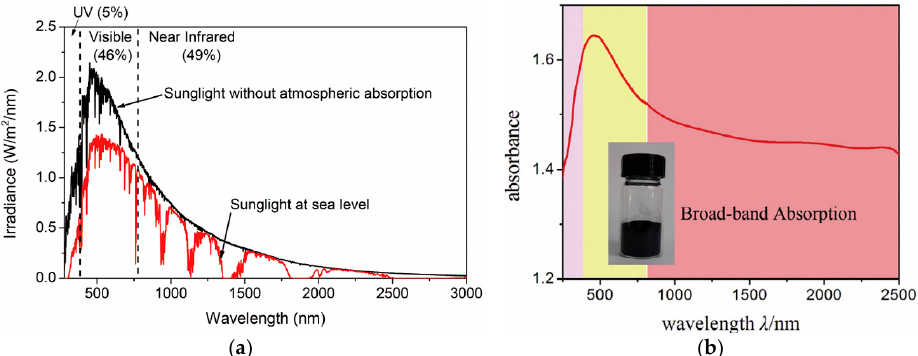
Figure 1. ( a ) Standard terrestrial solar spectral irradiation distributions by the American Society for Testing and Materials (ASTM G173). Reproduced from Ref. [64] with permission. Copyright 2017, Elsevier, and ( b ) absorption spectrum of ZrC nanoparticles. Reproduced from Ref. [67] with